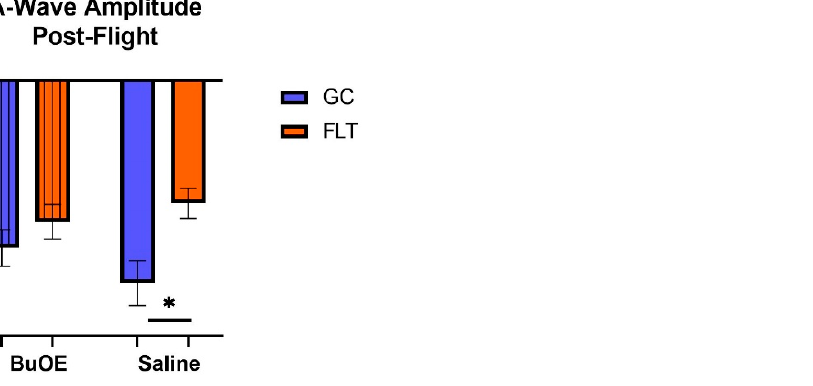
Figure 7. The post-flight comparison of the retina light sensitivity to the a-wave in saline or BuOE- treated flight (FLT) and habitat ground control (GC) groups. * Significantly different between flight and control ( p < 0.05). Bars represent the mean ± SEM (n = 8).